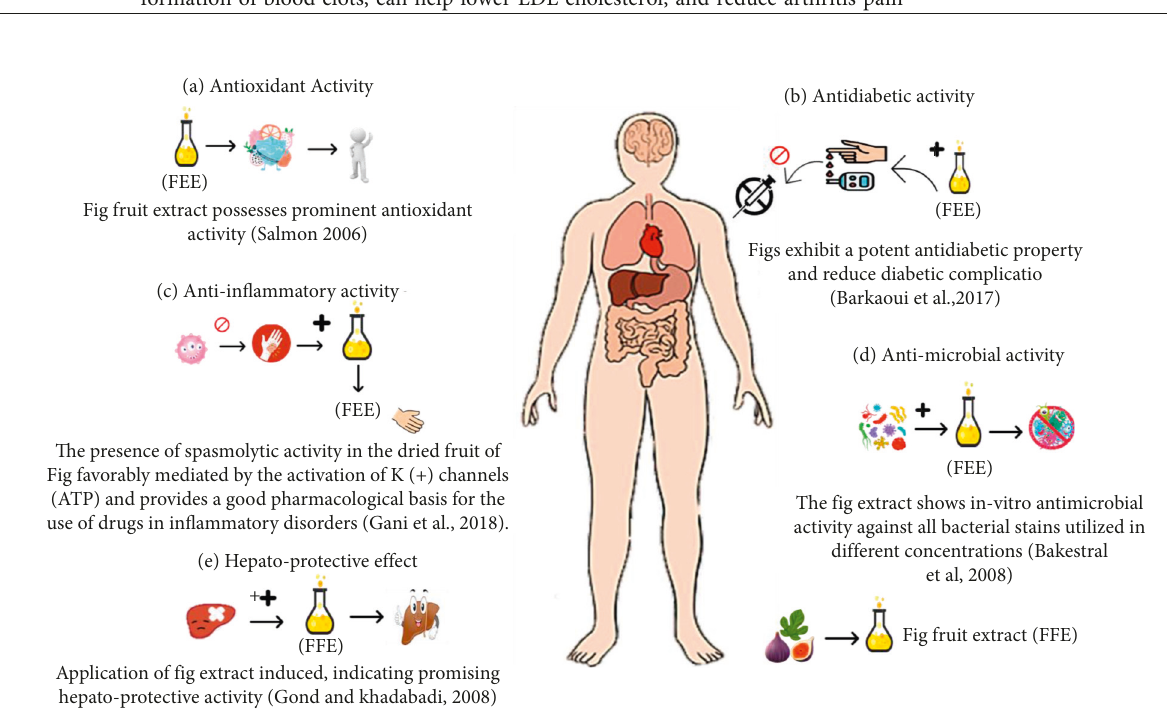
Figure 1: Bioactivities of Ficus species